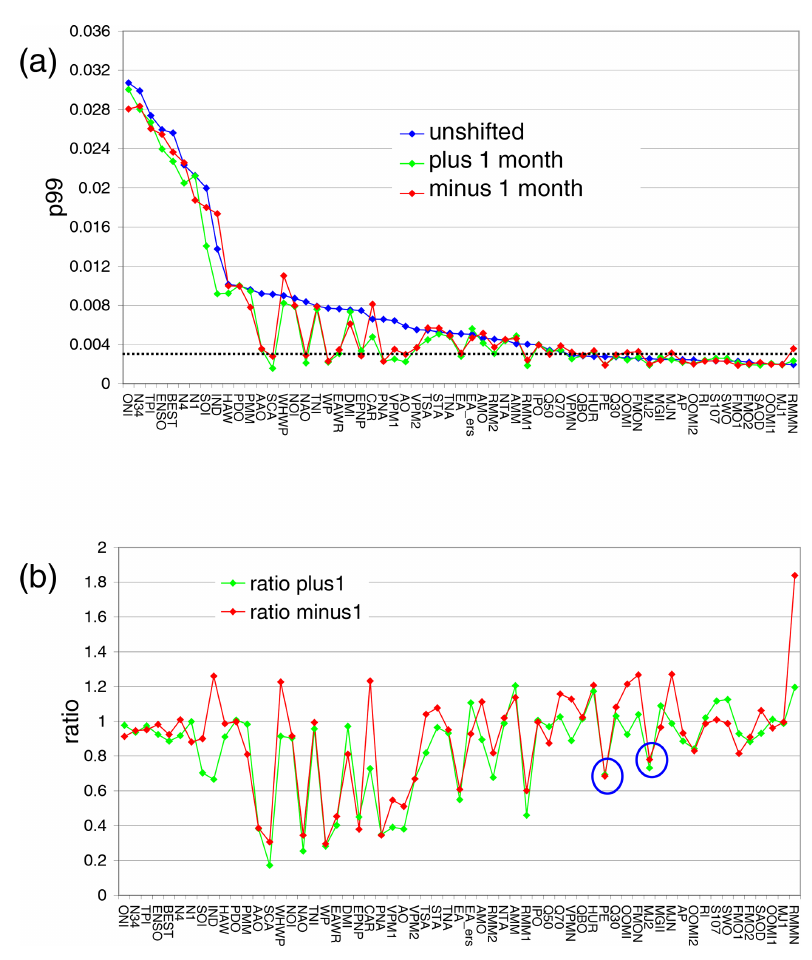
Figure A5. Top: 99th percentiles (p99) of the delta rms values for the original (blue) and shifted indices (green: plus 1 month; red: minus 1 month). The indices are sorted from highest to lowest p99 values for the unshifted original indices. Bottom: ratios of the p99 values of the shifted and original indices. Results are for the TCWV data set from satellite observations. The blue circles indicate teleconnection indices with p99 values below the threshold, but ratios of the shifted indices <